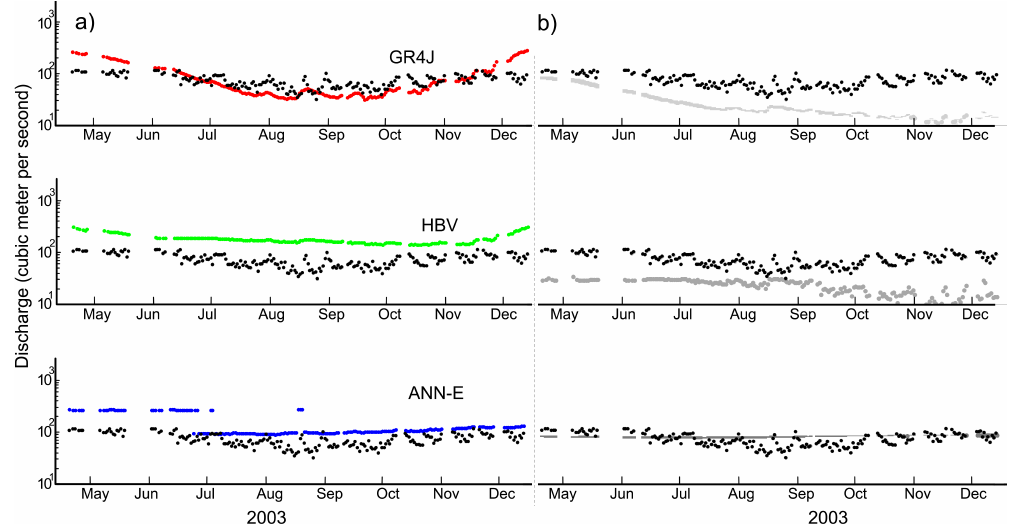
Figure 5. Low-flow forecasts in 2003 for a lead time of 90 days using (a) both climate mean P and PET (case 4) and (b) zero P and ensemble PET (case 5) as input for GR4J, HBV and ANN-E models. The gaps in the figures indicate non-low-flow days (i.e.